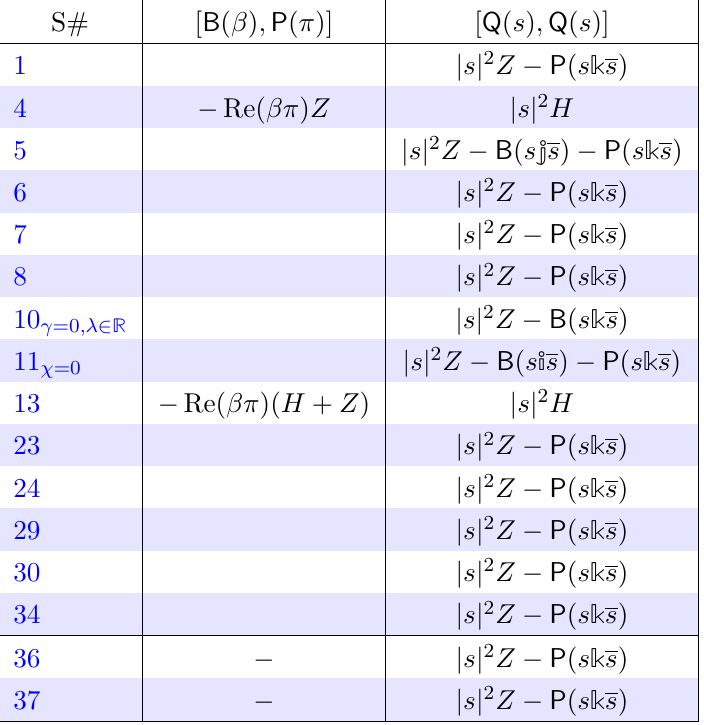
Table 7 . Central extensions of kinematical and aristotelian Lie